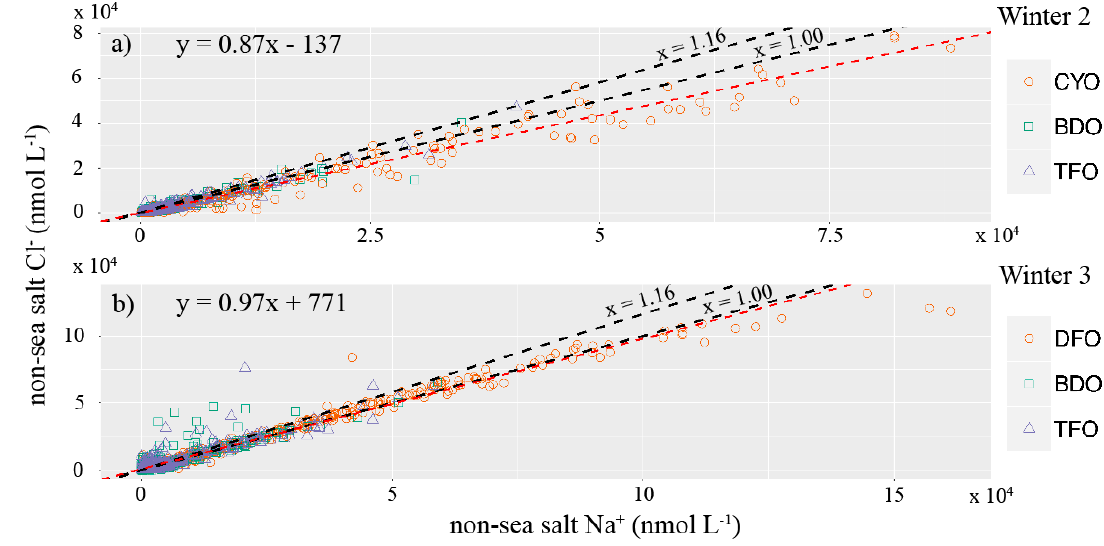
Figure 3. Scatter plot of non-sea salt Na + and Cl − for Winters 2 ( a ) and 3 ( b ) calculated using Mg 2+ as a conservative SSA tracer. The black lines demonstrate slopes of Cl − /Na + of 1.16 (SSA) or 1.00 (halite). The red dotted lines, and equation in the top left of each panel, show the line of best fit for a yearly data set, and has a slope of 0.87 in Winter 2 and 0.97 in Winter 3.